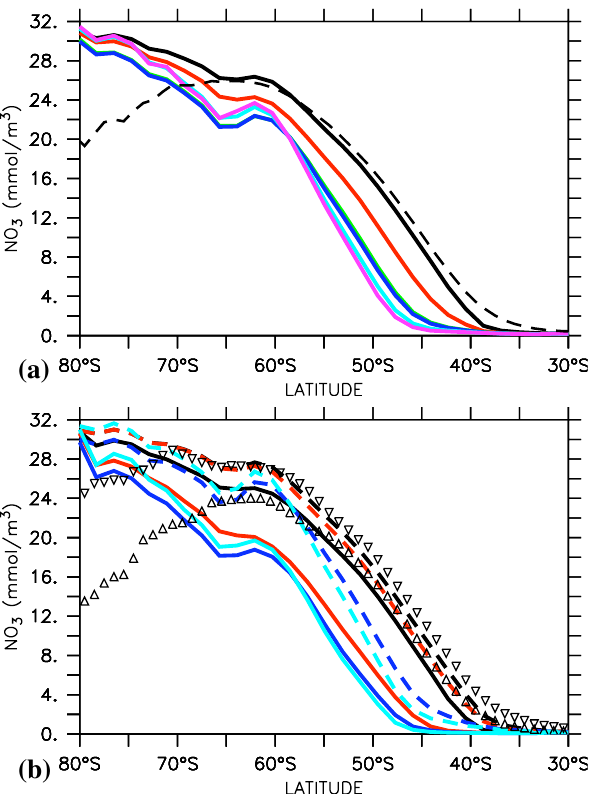
Fig. 2. (a) Zonally averaged simulated annual-mean surface nutri- ents in the control run (solid black) and in the World Ocean Atlas (Conkright et al., 2002) (dashed black line). Colored lines refer to model fields after 1 year of OIF (red), 7 years (green), 10 years (blue), 50 years (cyan), and 100 years (magenta) of continuous OIF south of 30 ◦ S. (b) Maximum (dashed) and minimum (solid) zon- ally averaged nitrate concentrations during the annual cycle in year 2010 of the reference experiment (black) and in the 1st year (red), 10th year (blue), and 50th year (cyan) of the continuous OIF exper- iment. Respective maximum and minimum values from the World Ocean Atlas are depicted as downward and upward pointing trian- gles, respectively. Units are mmolm − 3 .